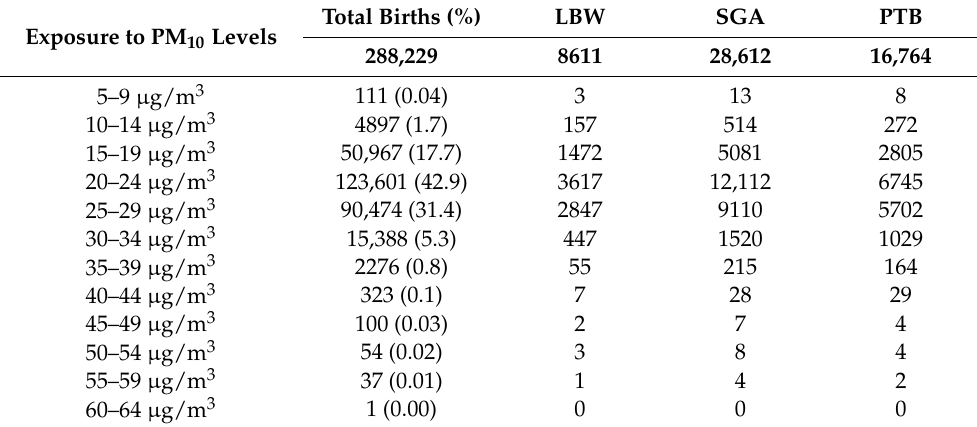
Table 2. Birth outcomes by mean level of exposure to PM 10 during pregnancy,